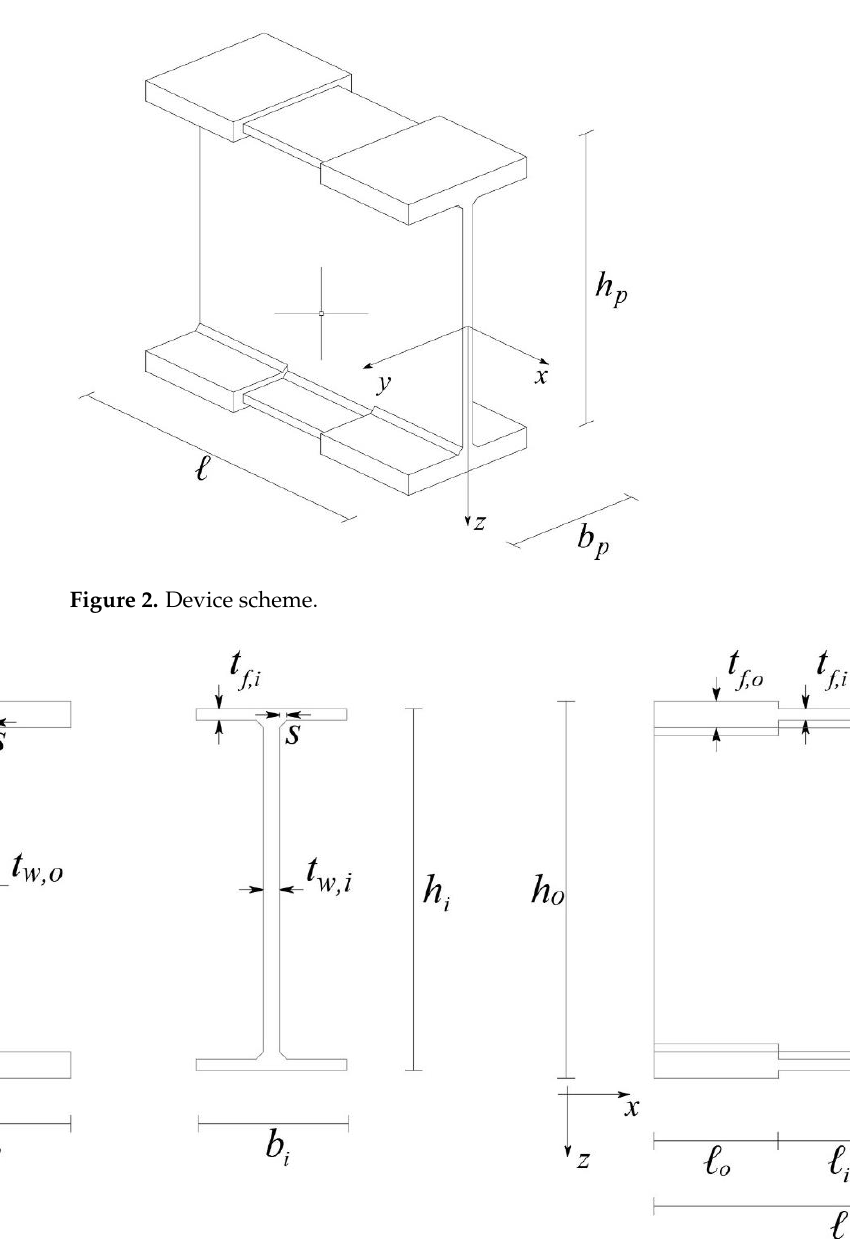
Figure 3. Device geometry: ( a ) cross sections of the inner and outer portions; ( b ) lateral view.